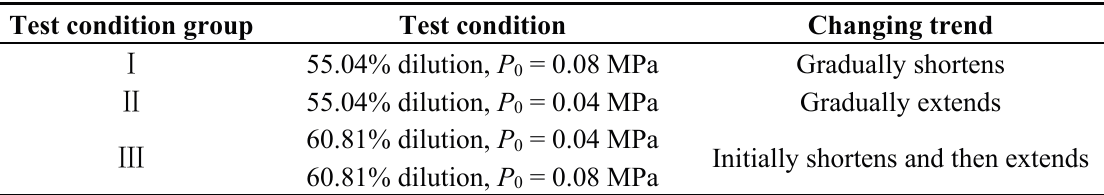
Table 3. Overall ignition delay changing trends with increasing compression